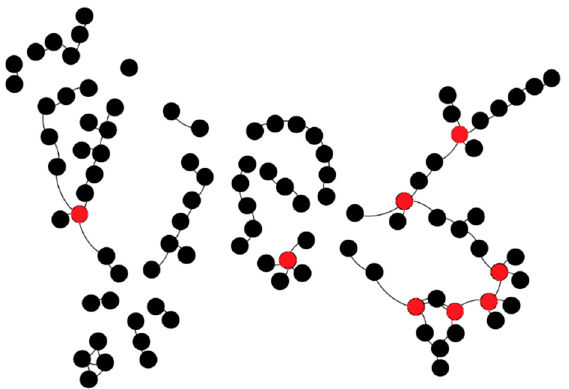
Figure 11. The state of the graph after the removal of all vertices up to and including the fifth degree with the all the marked vertices of the fourth degree.